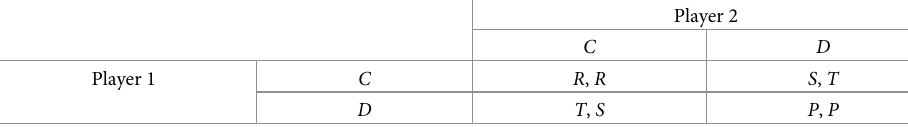
Table 2. Payoff matrix of a symmetric 2-player, 2-action normal-form